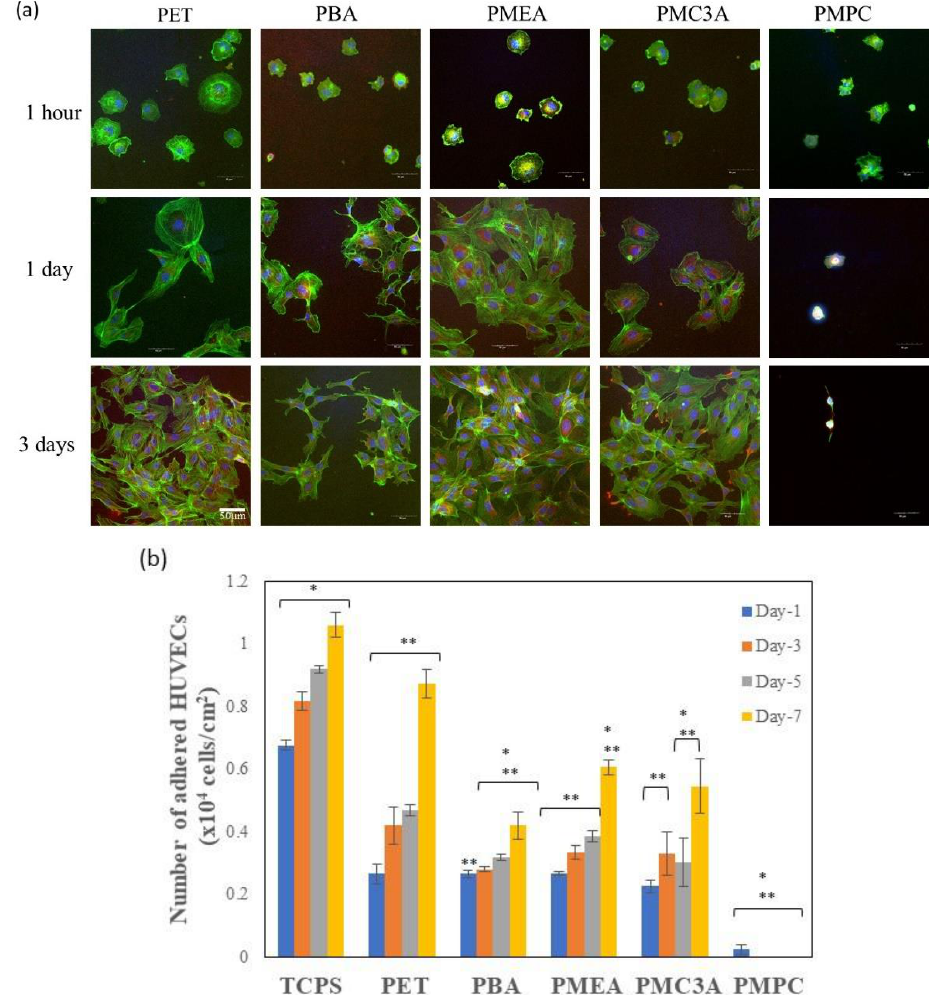
Figure 2. ( a ) CLSM images of PMEA-analogue-coated substrates. Blue: cell nuclei; green: vinculin; red: actin fibers. White bar indicates 50 μ m. ( b ) Numbers of adhered HUVECs on PMEA-analogue- coated substrates at 1, 3, 5, and 7 d. The data represent the mean ± SD ( n = 3), ** p < 0.05 compared with TCPS and * p < 0.05 compared with PET.